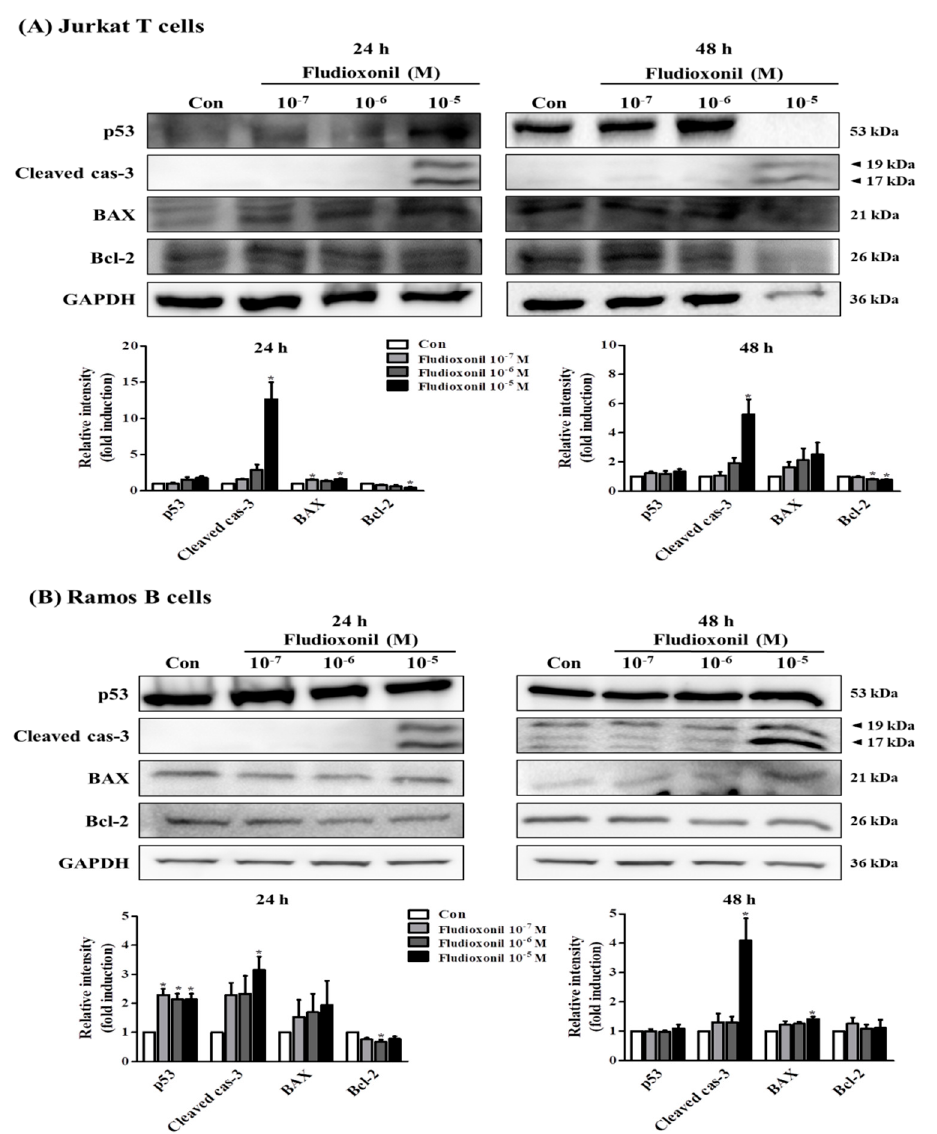
Figure 6. Protein expression of apoptosis-related genes in Jurkat T cells and Ramos B cells. ( A ) Jurkat T cells and ( B ) Ramos B cells were treated with fludioxonil 10 − 7 –10 − 5 M for 24 or 48 h. The cell lysates were prepared and the target proteins were analyzed by Western blotting. The protein expression of apoptosis-related genes, such as p53, BAX, cleaved caspase-3, and Bcl-2, are shown as representative Western blot images. All bands were normalized by GAPDH and presented as % of controls. The value of the control (DMSO) was set as 1 and the values of the treatment groups were indicated as fold induction vs. control. The data are shown as the means ± standard deviation (SD) of three independent experiment. * p < 0.05 as compared with the control.